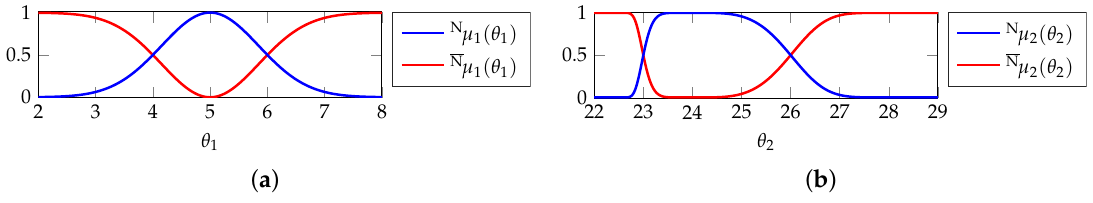
Figure 2. Fuzzy membership functions N µ s ( θ s ) and N µ s ( θ s ) for two exemplary sensor measurements representing their normal and abnormal conditions, respectively. ( a ) Normal and abnormal condition for sensor S 1 ; ( b ) Normal and abnormal condition for sensor S 2